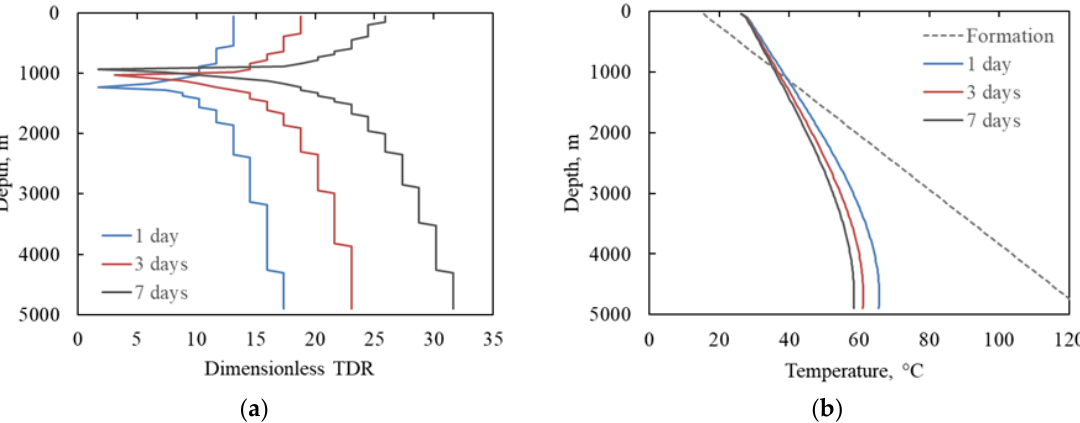
Figure 8. The sensitivity analysis of thermal disturbance with varying circulation times: ( a ) TDR and ( b ) fluid temperature in the annulus.